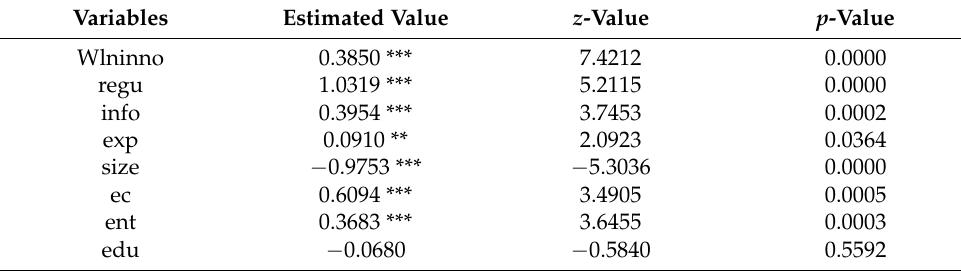
Table 6. SAR estimation results of factors influencing urban innovation capacities.